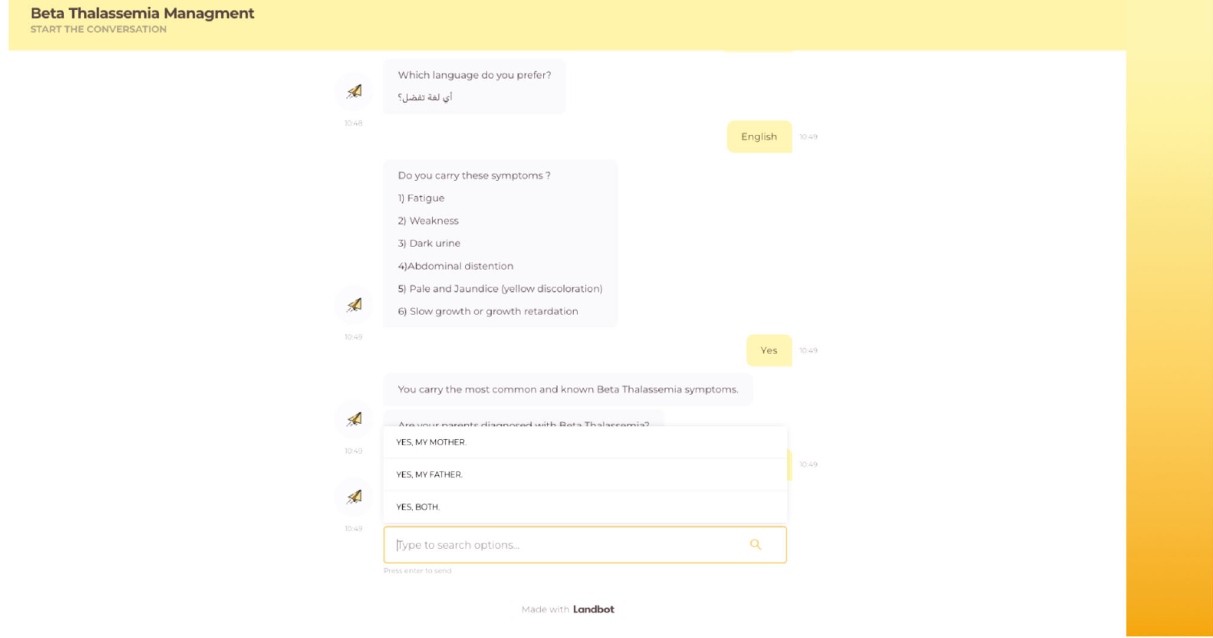
Figure 7: Screenshot of the conversation between the chatbot and